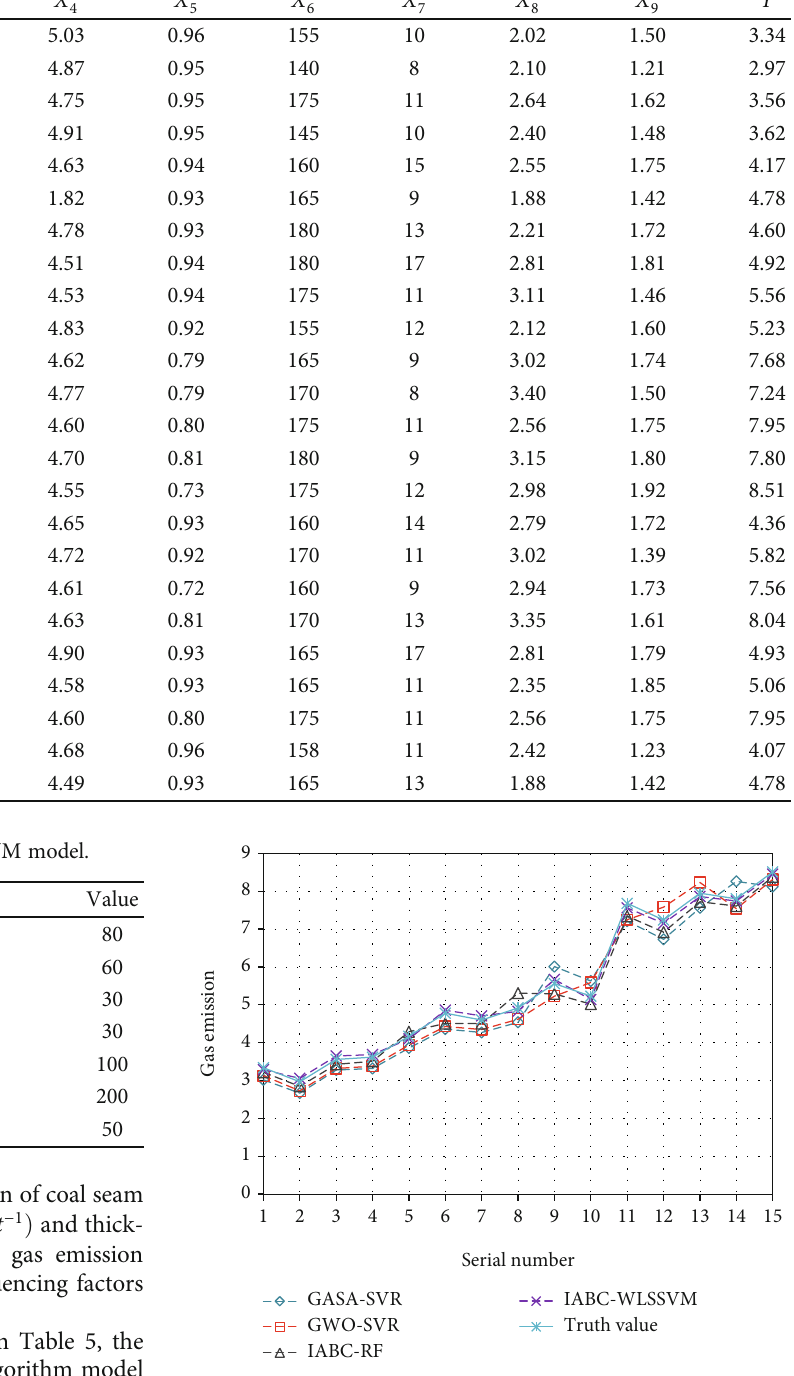
Figure 9: Comparison of 15 groups of prediction